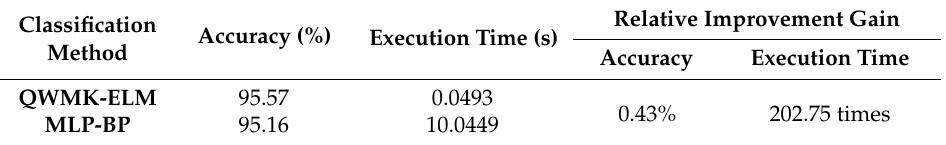
Table 9. Accuracy and execution time improvement gain with respect to the best competitor for Dataset II.